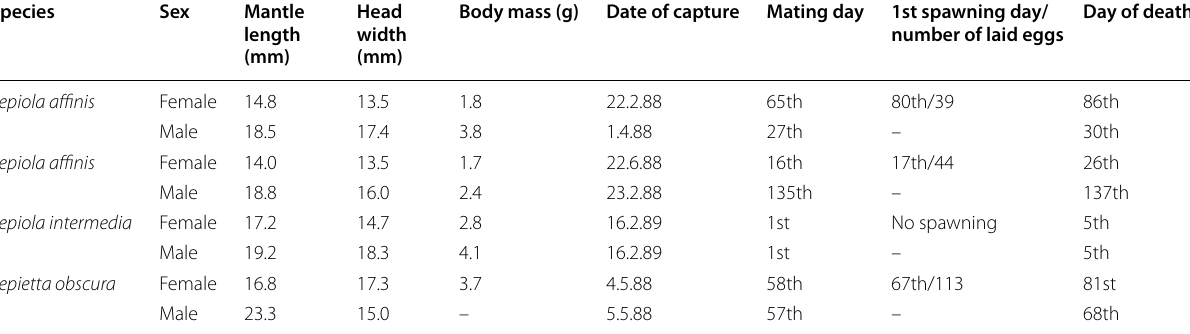
Table 1 Sepioline pair data